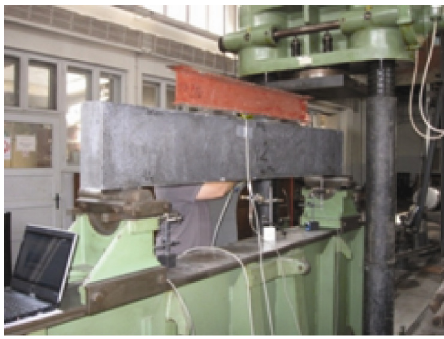
Fig. 8. Testing a beam at the laboratory of the IMS Institute